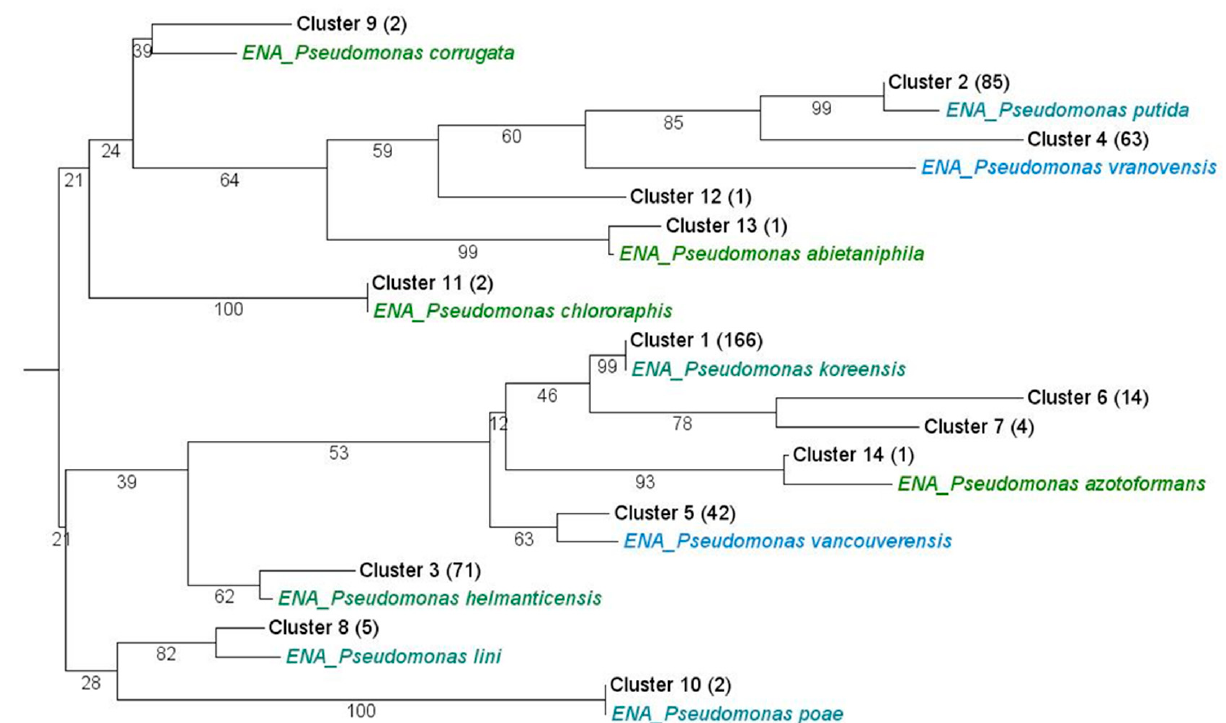
Figure 1. Phylogenetic classification. Unrooted neighbor-joining tree based on nucleotide differences between partial 16S rRNA gene sequences of the isolates as well as closely related strains. All sequences were separated into 14 clusters using an identity threshold of 99.5%. Numbers after the cluster designation indicate the number of sequences in each cluster, and numbers at the branches the bootstrapping values. Table 1. Impact of soil parameters on the biological activities of Pseudomonas bacteria. Correlation coefficients and significance of correlation are given. The significance of the positive or negative Spearman’s rank correlation coefficient is reported using the following convention: * p < 0.05. The following datasets were used for analysis: AcK, AcP and AcFe, K and P solubilization and siderophore production activities of Pseudomonas strains; gravimetric soil moisture; pH; Soil-P, plant available phosphate; TOC and TN, total organic carbon and nitrogen, as well as plant biomass (PB) and root biomass